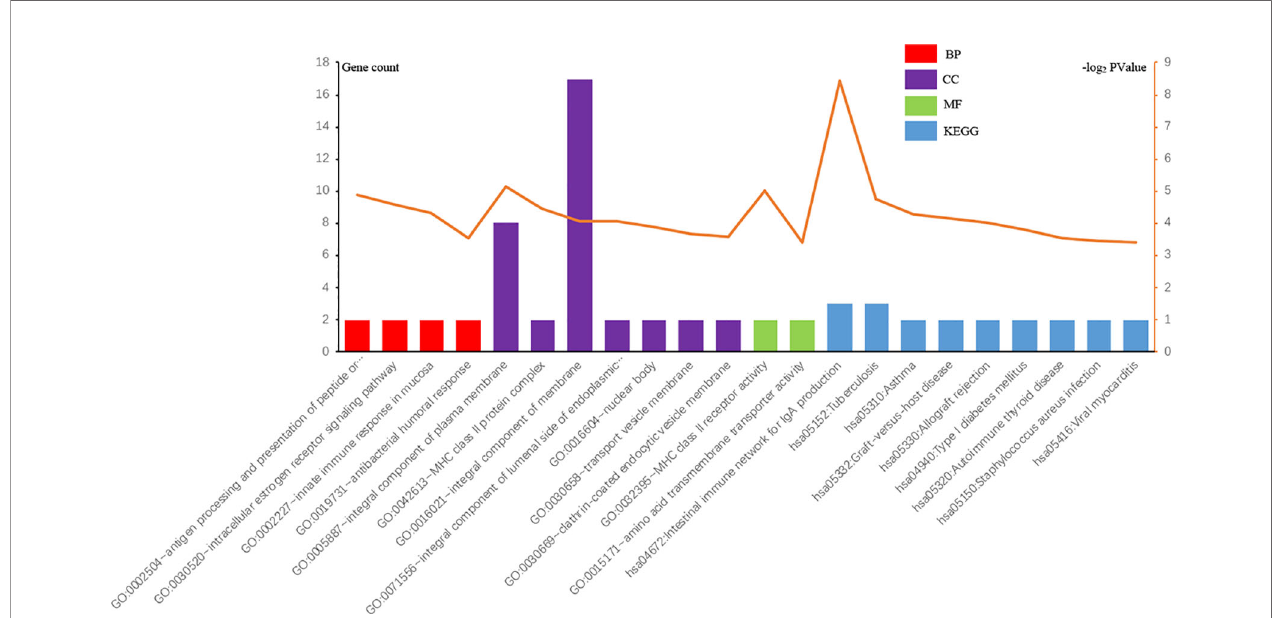
FIGURE 4 | GO and KEGG pathways of DEGs meaningfully enriched in